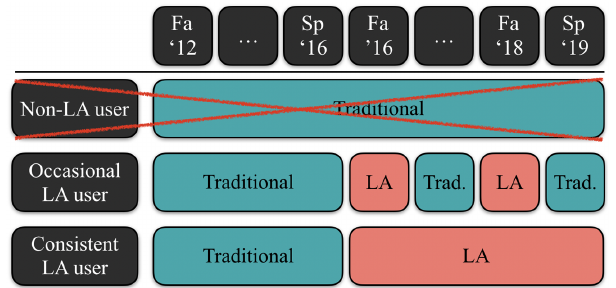
FIG. 1. The three types of instructors in the physics department. To control for instructors self-selection into using LAs, we only analyzed data for courses taught by the occasional and consistent LA-using faculty.